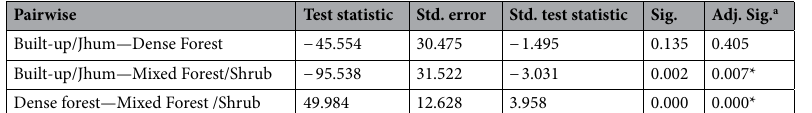
Pairwise Test statistic Std. error Std. test statistic Sig.